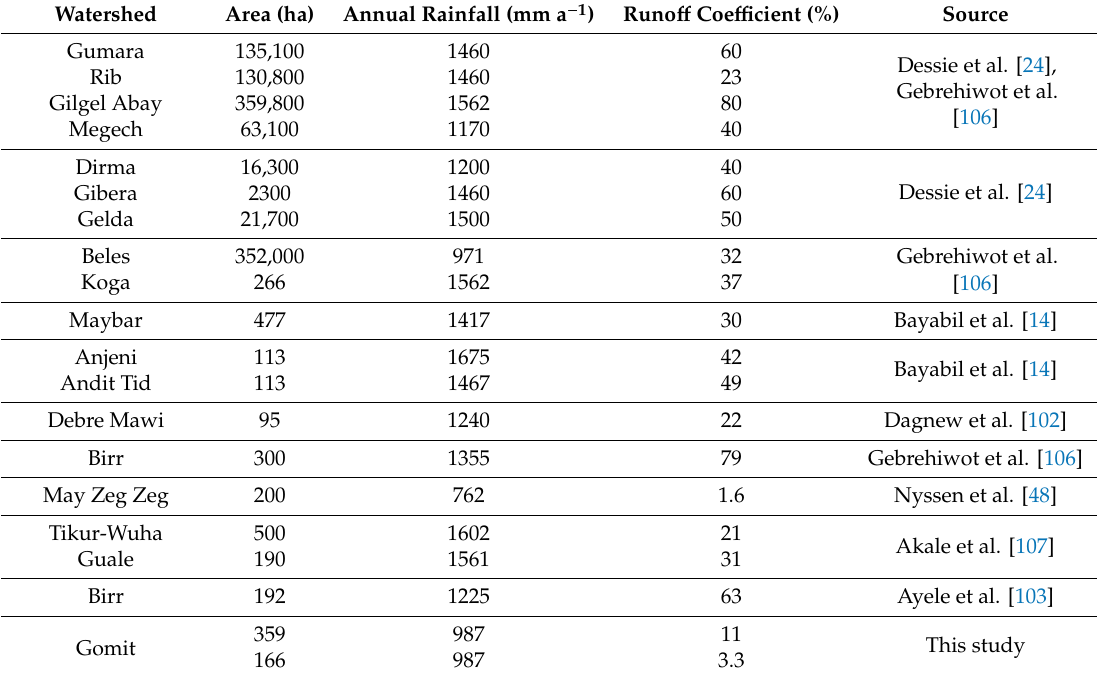
Table A3. Watershed size, annual rainfall, and annual runo ff coe ffi cients for watersheds in the Ethiopian